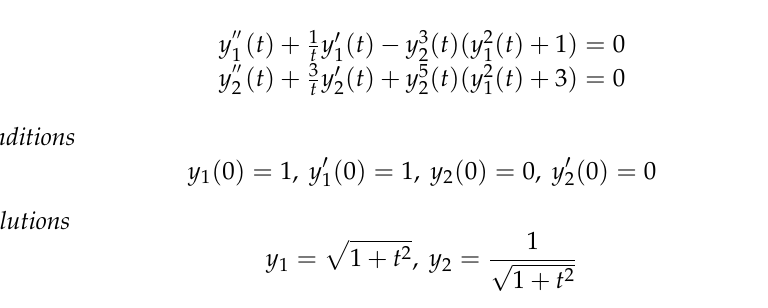
Figure 4. Relative errors of y 2 ( t ).